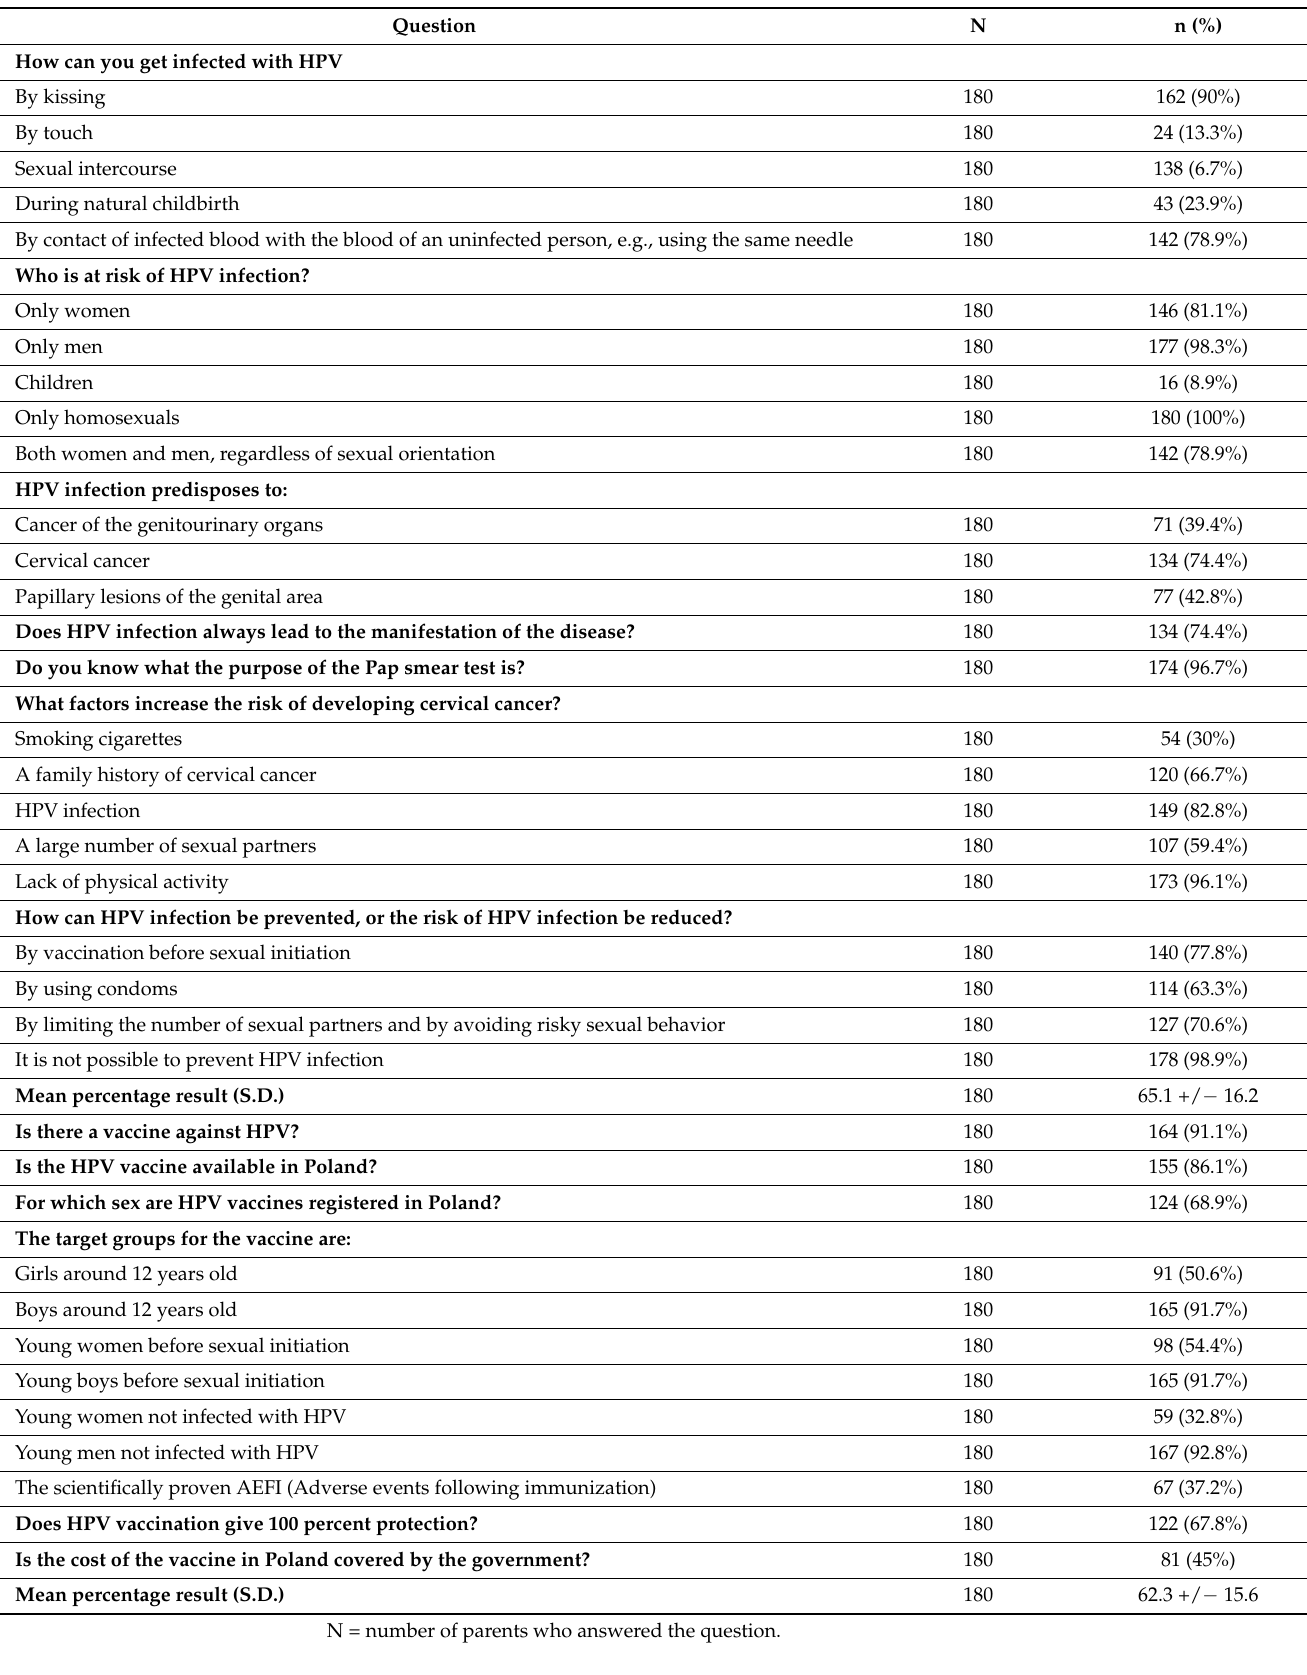
Table 6. Knowledge about the HPV virus and the HPV vaccine—correct answers to component